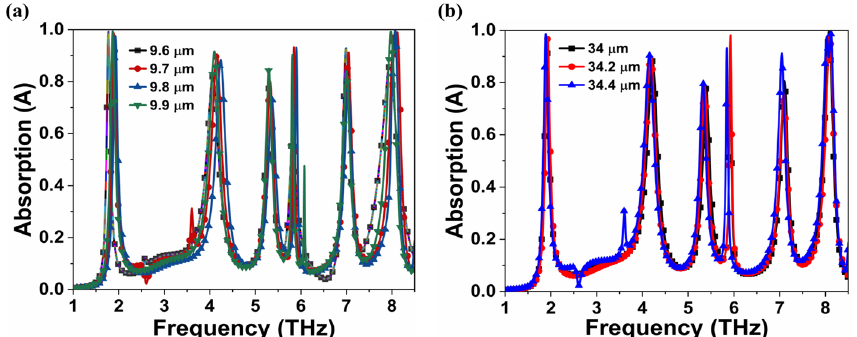
Figure 6. Absorption response at different ( a ) substrate thickness ( h s ) from 9.6 to 9.9 μm and ( b ) unit cell dimension ( a ) from 34 to 34.4